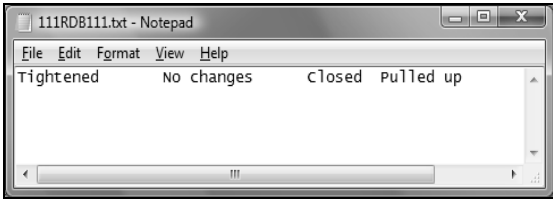
Fig. 7. The text file containing student’s facial